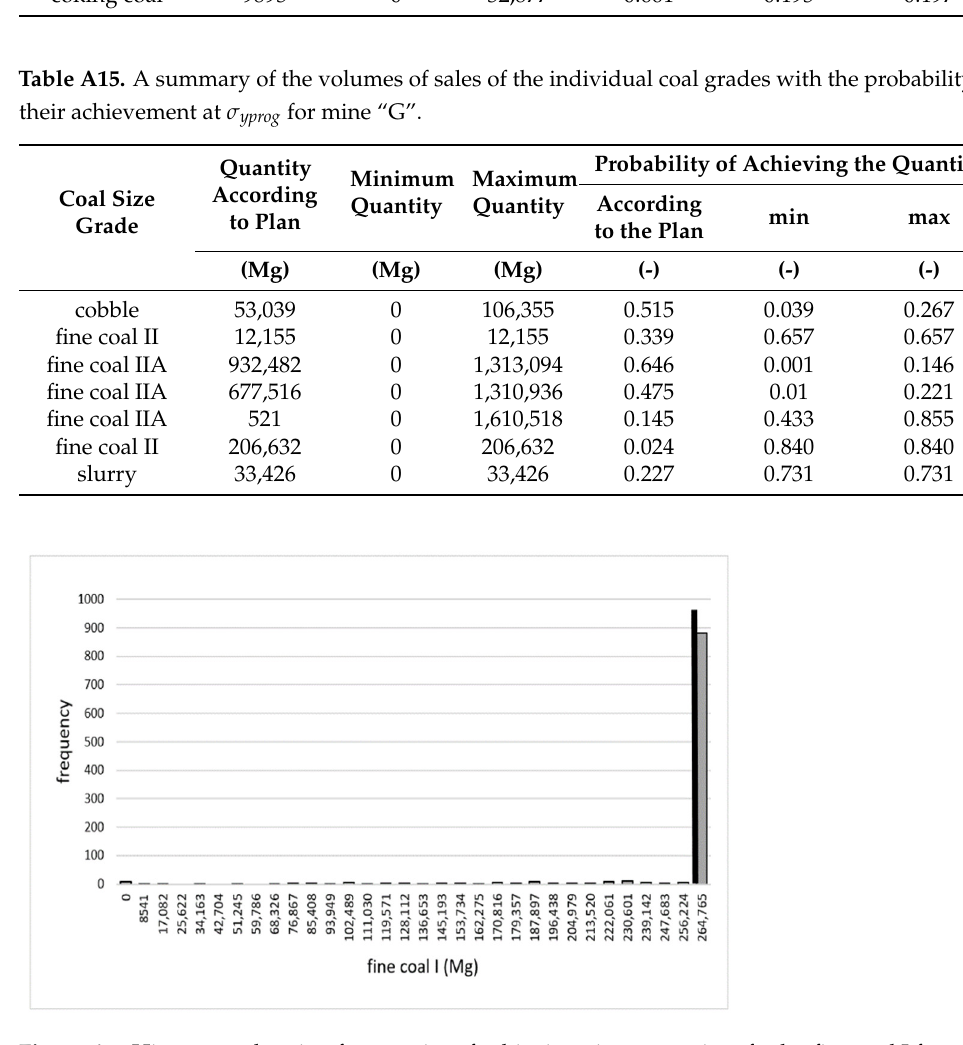
Figure A1. Histogram showing frequencies of achieving given quantity of sales fine coal I for mine “A” with σ yprog.